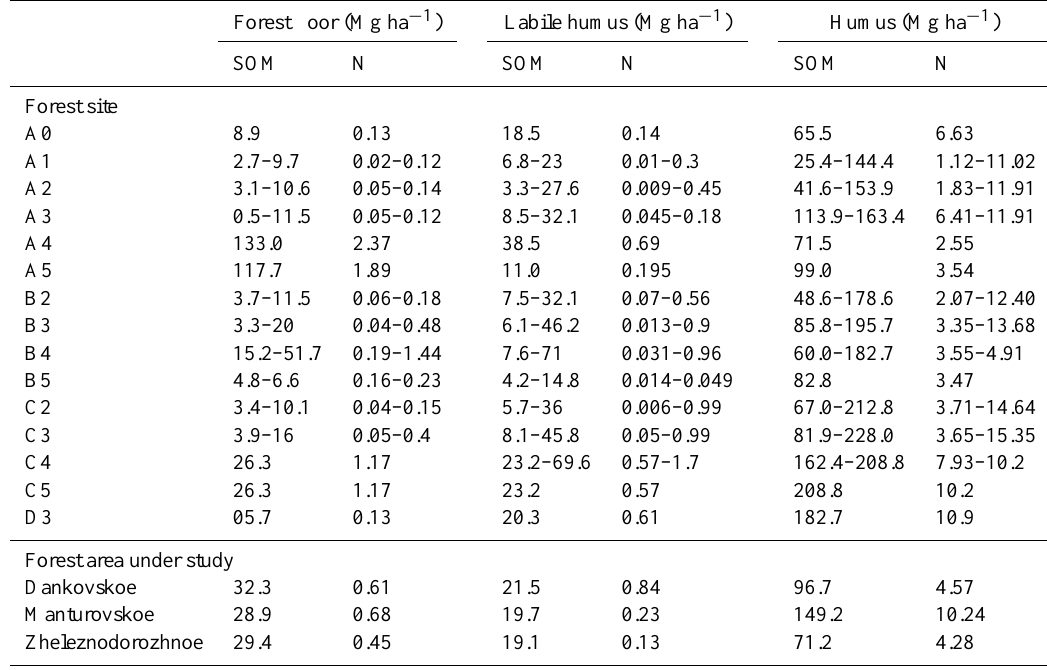
Table 2. Variation in characteristics of soil for different forest sites. Values on organic matter and nitrogen pools are obtained from special database (Chestnykh et al., 1999, 2004, 2007) and used for the initialization of the ROMUL sub-model of soil organic matter dynamics. These amounts are also influenced by species composition in overstorey and geographical